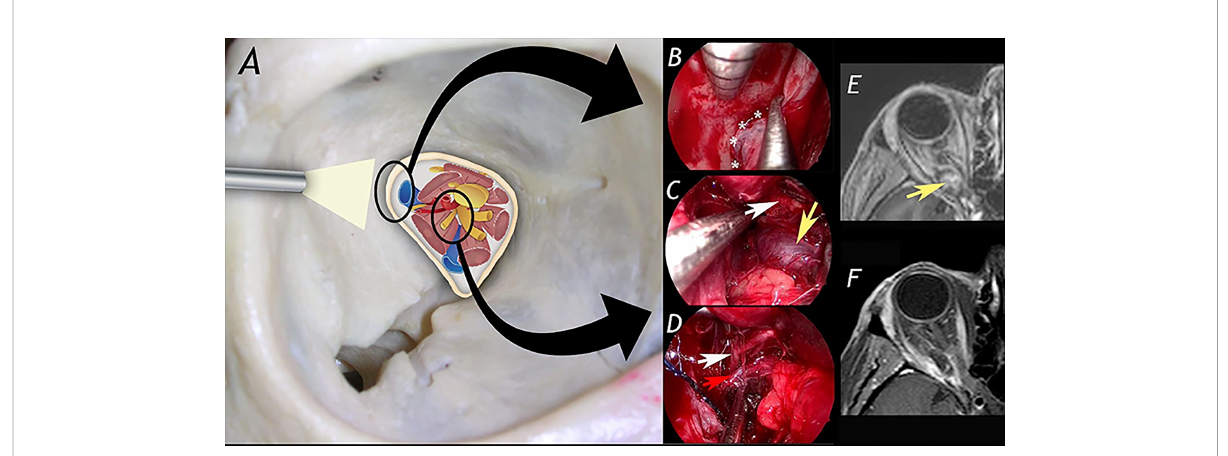
FIGURE 1 A 42-year-old woman affected by right orbital apex cavernous hemangioma (with progressive worsening of right visual fi eld) was treated via superior eyelid endoscopic-assisted approach with complete resection of the lesion and no signi fi cant morbidity. (A) schematic drawing showing anatomical structures in the orbital apex. In (B – D) surgical steps of the procedure. (B) : exposure of the lateral aspect of the superior orbital fi ssure. (C) : identi fi cation of the cavernous hemangioma. (D) : dissection of the lesion from superior division of III cranial nerve and ophthalmic artery. (E, F) show pre- and post-operative MRI. White asterisks: lateralaspect of superior orbital fi ssure; white arrow: superior division of the oculomotor nerve; yellow arrow: cavernous hemangioma; red arrow: ophthalmic artery.